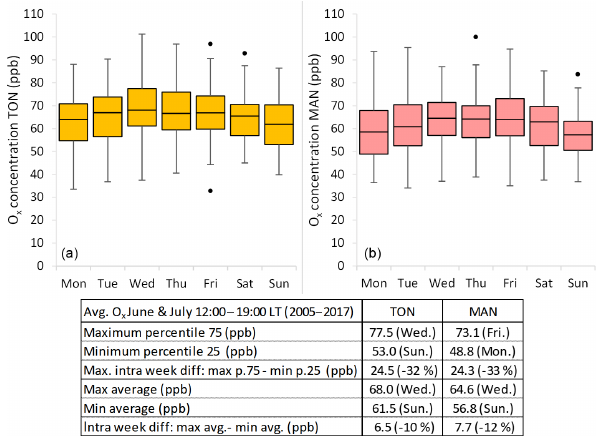
Figure 14. Box plots of O x measured in TON (a) and MAN (b) (12:00 to 19:00LT) per weekday June and July 2005–2017 for those days with δ O x TON − CTL > 0 ( n = 545 for TON and n = 479 for MAN of valid data). Each box represents the central half of the data between the lower quartile (P25) and the upper quartile (P75). The line across the box displays the median values. The whiskers that extend from the bottom and the top of the box represent the extent of the main body of data. The outliers are represented by black